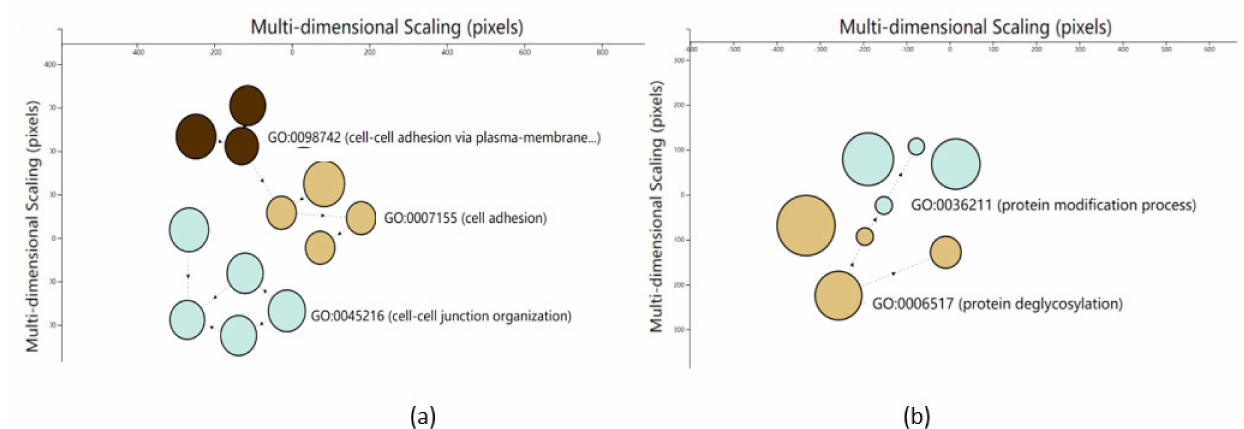
Figure 7. Clustering of enriched terms of LS and RA. In total, 12 GO terms ( a ) and 8 GO terms ( b ) were enriched in the biological process namespace using the genes within 200 Kb of the significant SNPs of LS and RA. (The results of PW are not listed because the genes within 200 Kb of the significant SNPs of PW were enriched to non-significant GO terms.) FunSet software automatically identified 3 and 2 clusters of LS and RA, respectively, using the eigengap approach [28]. Table 3. Details of the pathways enriched by the genes within 200 Kb of the significant SNPs of traits.